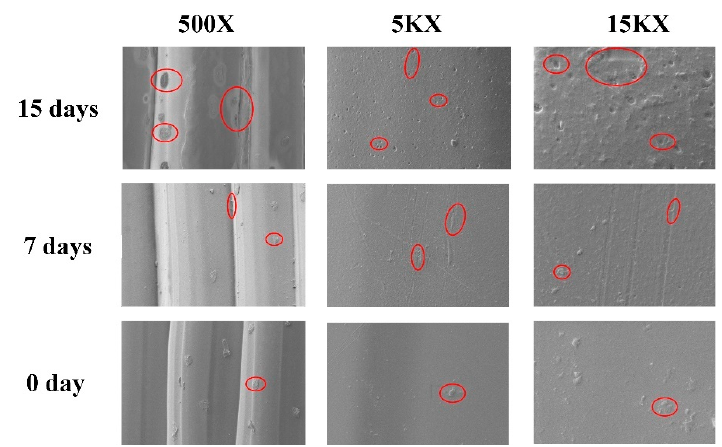
Figure 6. SEM images of PAB immersed in the NaOH medium at different magnifications (500×, 5000×, and 15,000×) and degradation times (days 0, 7, and 15). The red circles indicate the degradation condition of PAB.